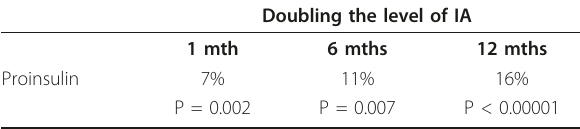
Table 2 The relationship between IA and proinsulin